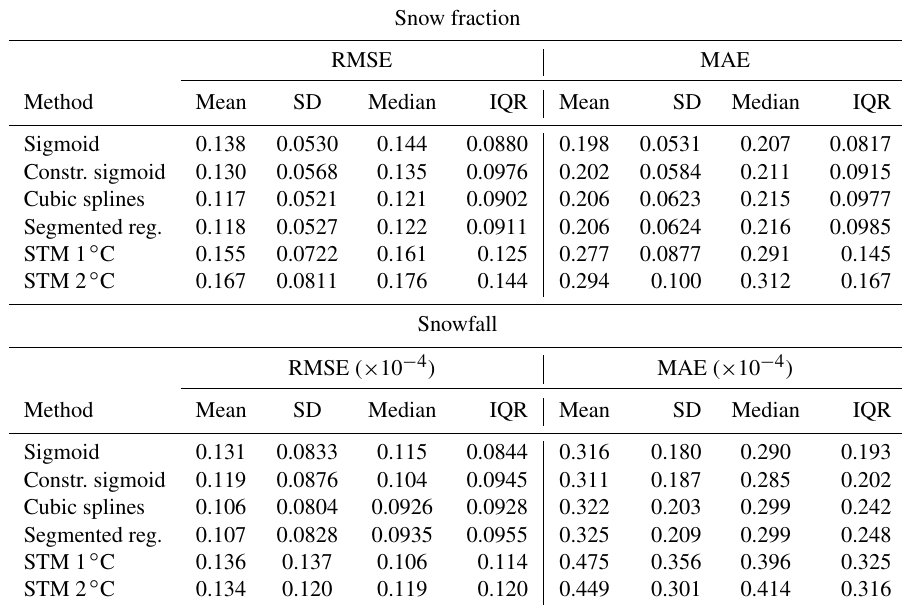
Table 1. Summary statistics of the distributions of the RMSE and MAE for snow fraction and snowfall in ERA5. The mean, standard deviations, median, and interquartile range are shown.